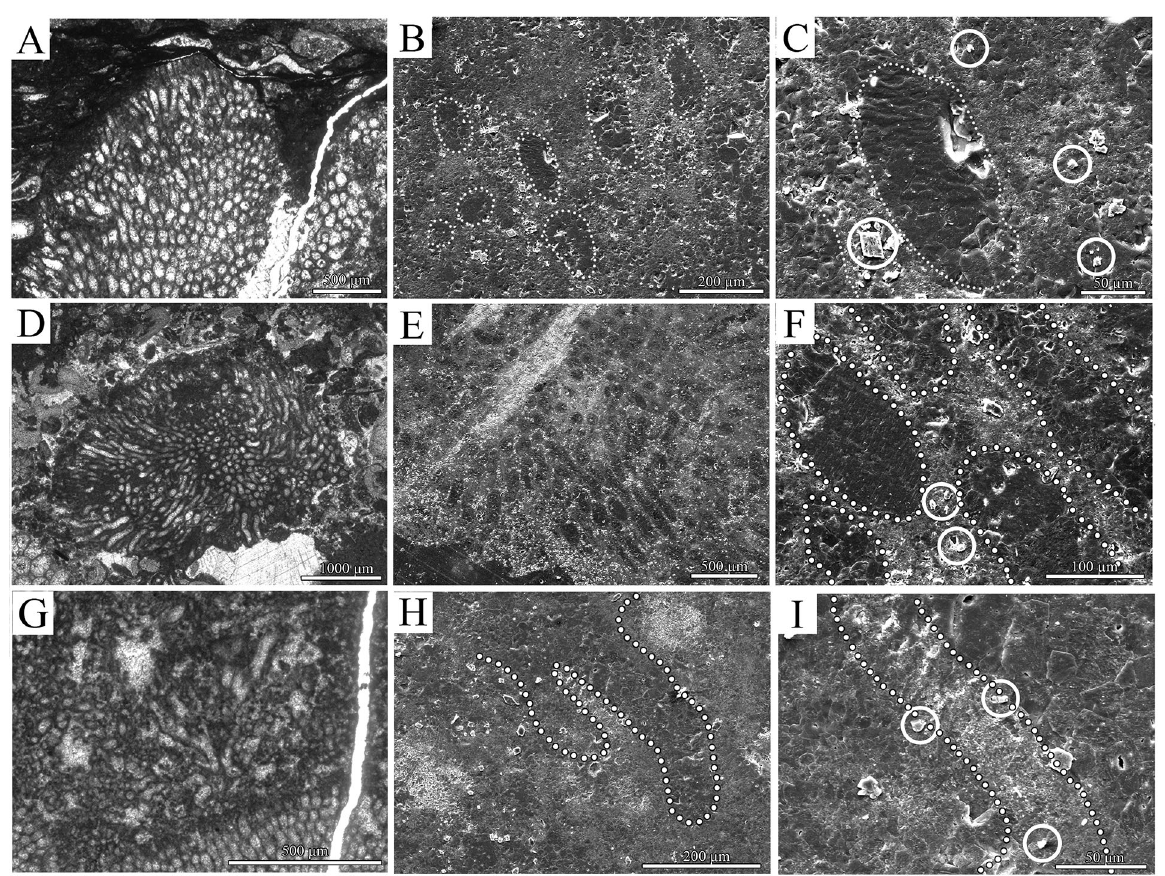
Fig. 4. Comparison of thin section photomicrographs and equivalent SEM photomicrographs. A , thin section photomicrograph of a porostromate problematicum at 1.3 m in the section. B , SEM photograph of the porostromate problematicum in Fig. 4A outlining the tubules from the walls with a dotted line. C , closer SEM photograph of the porostromate problematicum in 4A outlining the tubules from the walls with a dotted line and possible microdolomite circled. D , thin section photomicrograph of a porostromate problematicum at 0.65 m in the section. E , SEM photograph of the porostromate problematicum in 4D showing many tubules. F , closer SEM photograph of the porostromate problematicum in 4D outlining the tubules from the walls with a dotted line and possible microdolomite circled. G , thin section photomicrograph of microproblematicum Hedstroemia at 1.3 m in the section. H , SEM photograph of the Hedstroemia in 4G outlining the tubules with a dotted line. I , closer SEM photograph of the Hedstroemia in 4G outlining the tubules with a dotted line and possible microdolomite